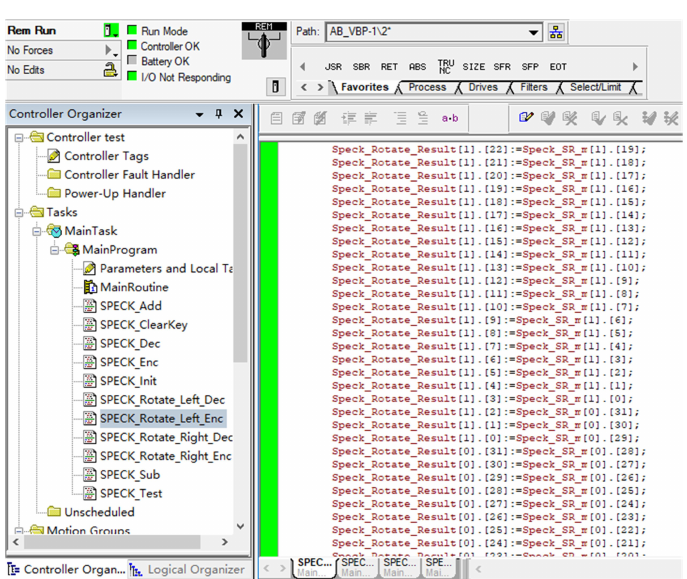
Figure 3: Code Snippet of Hard-coded